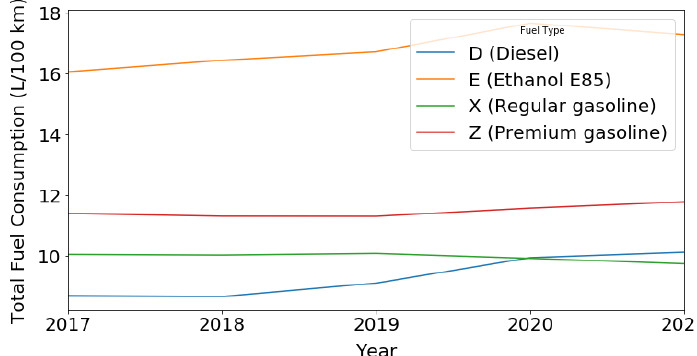
Figure 8. Total fuel consumption (L/100 km) of each fuel type over